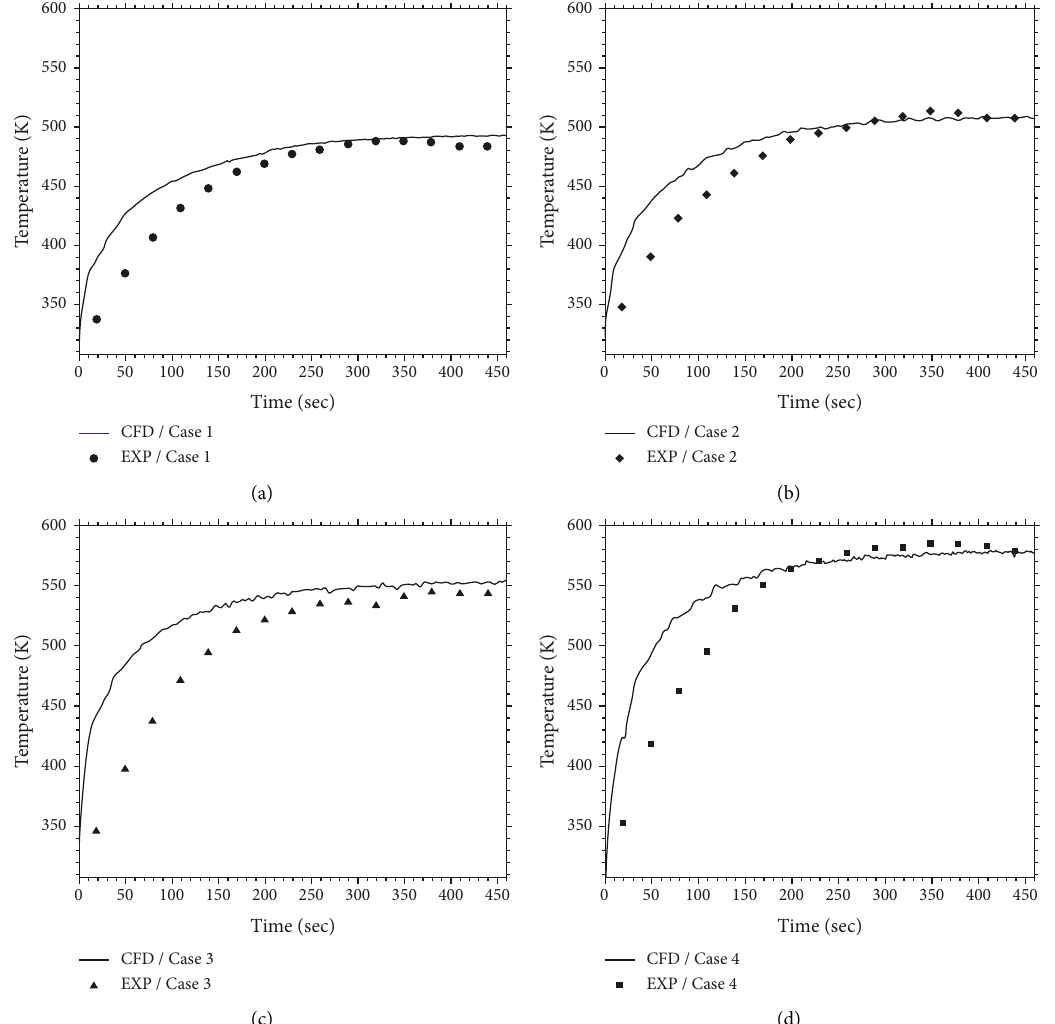
Figure 9: Confrontation between experimental and numerical profiles at ceiling during growth and fully developed fire phase. (a) Fire scene 1. (b) Fire scene 2. (c) Fire scene 3. (d) Fire scene